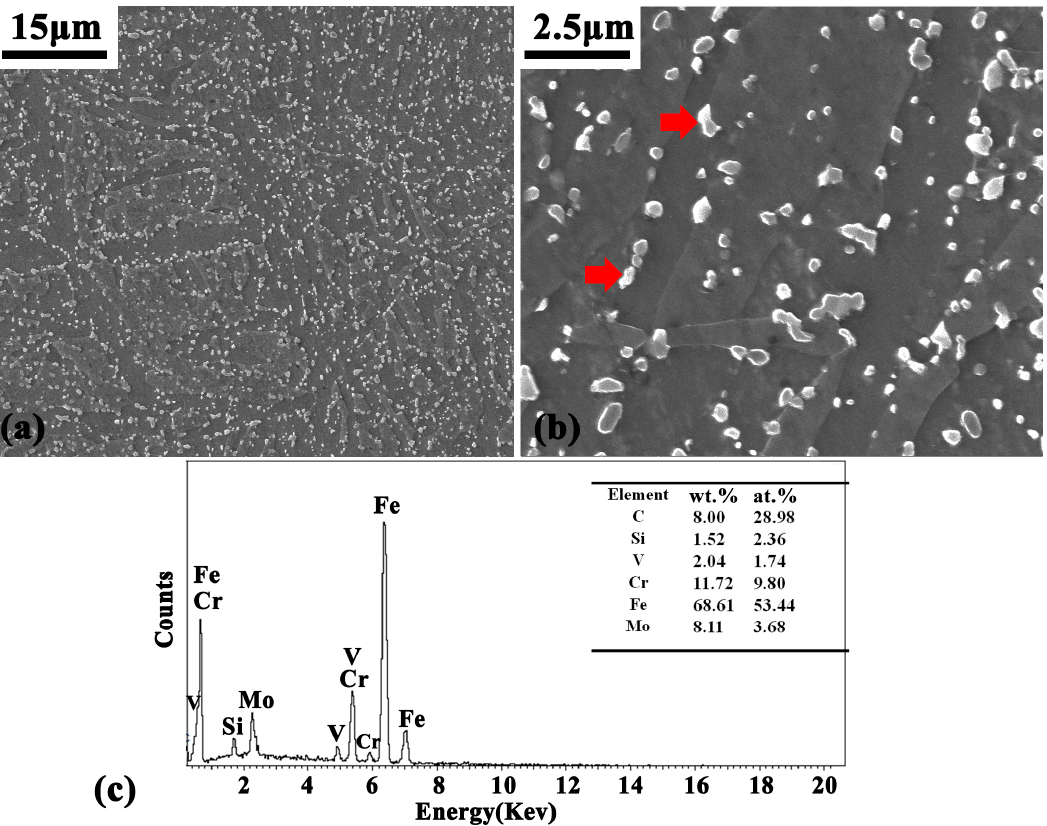
Figure 1. Original microstructure of H13 steel in this study, ( a , b ) images of the secondary electronic (SE) mode and ( c ) energy dispersive spectrometer (EDS) of scanning electron microscopy (SEM) analysis of the carbides (red arrows in ( b )).